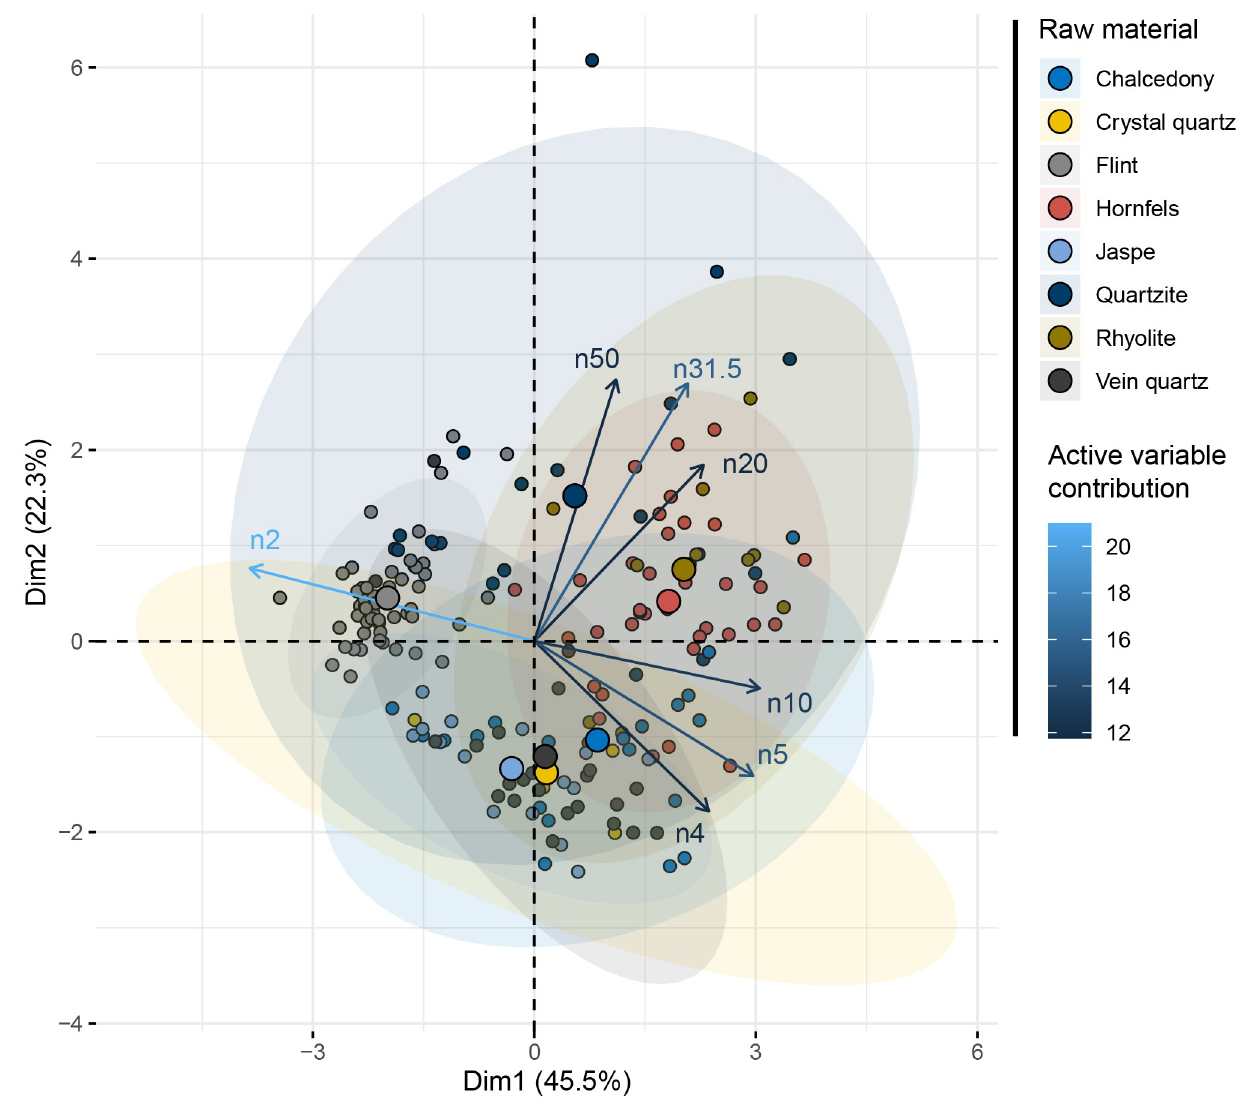
Fig 15. PCA of the SA dataset and the EU dataset [20, 21], having ‘raw material’ as a supplementary